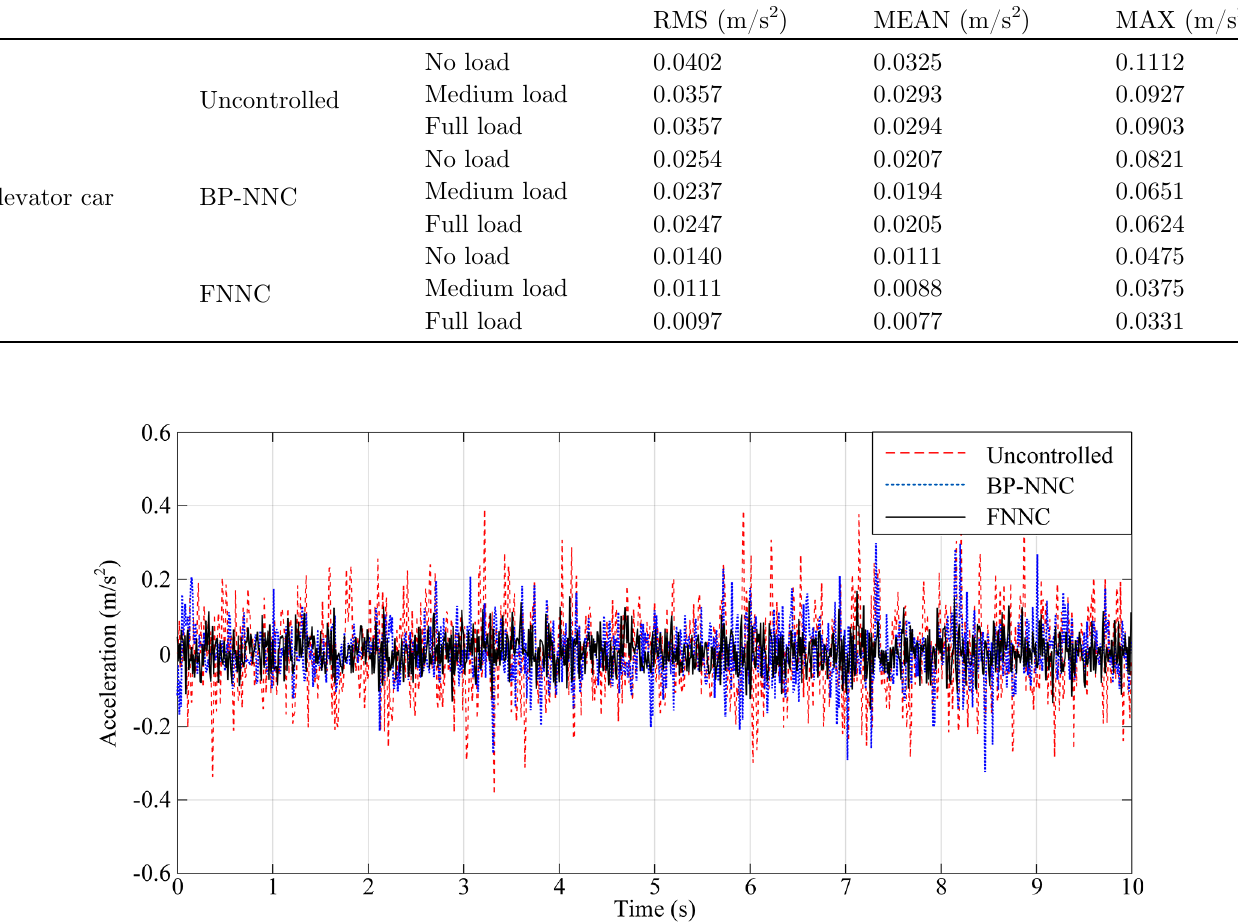
Table 4. Time-domain response results of horizontal vibration acceleration of the elevator car.